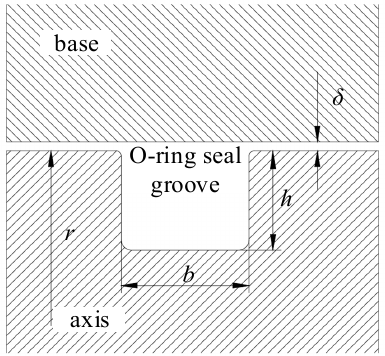
Figure 5. Diagram of standard O-ring groove structure.